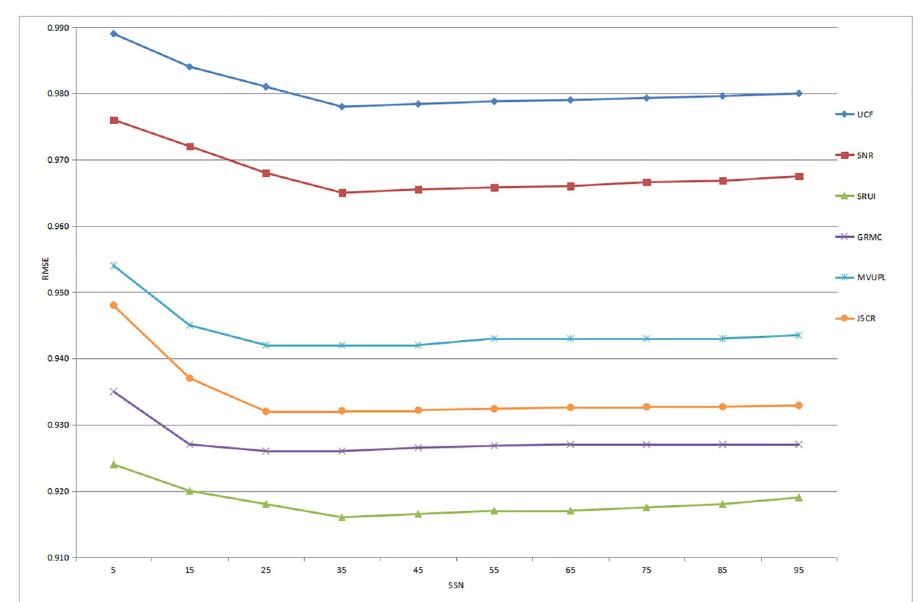
Fig 6. Prediction accuracy of all the comparison methods for different numbers of social similar neighbors based on the Epinions dataset (RMSE).